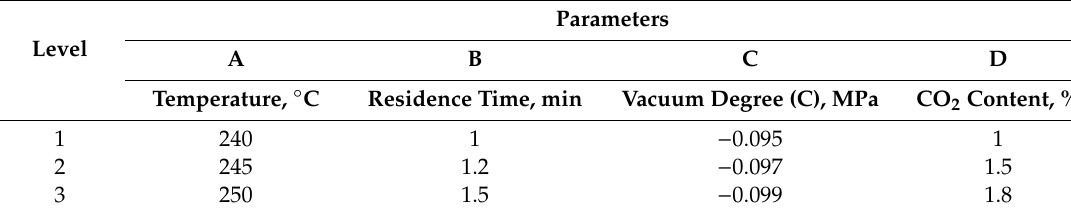
Table 2. Preparation of ABS resin with low VOC using supercritical fluid extraction.